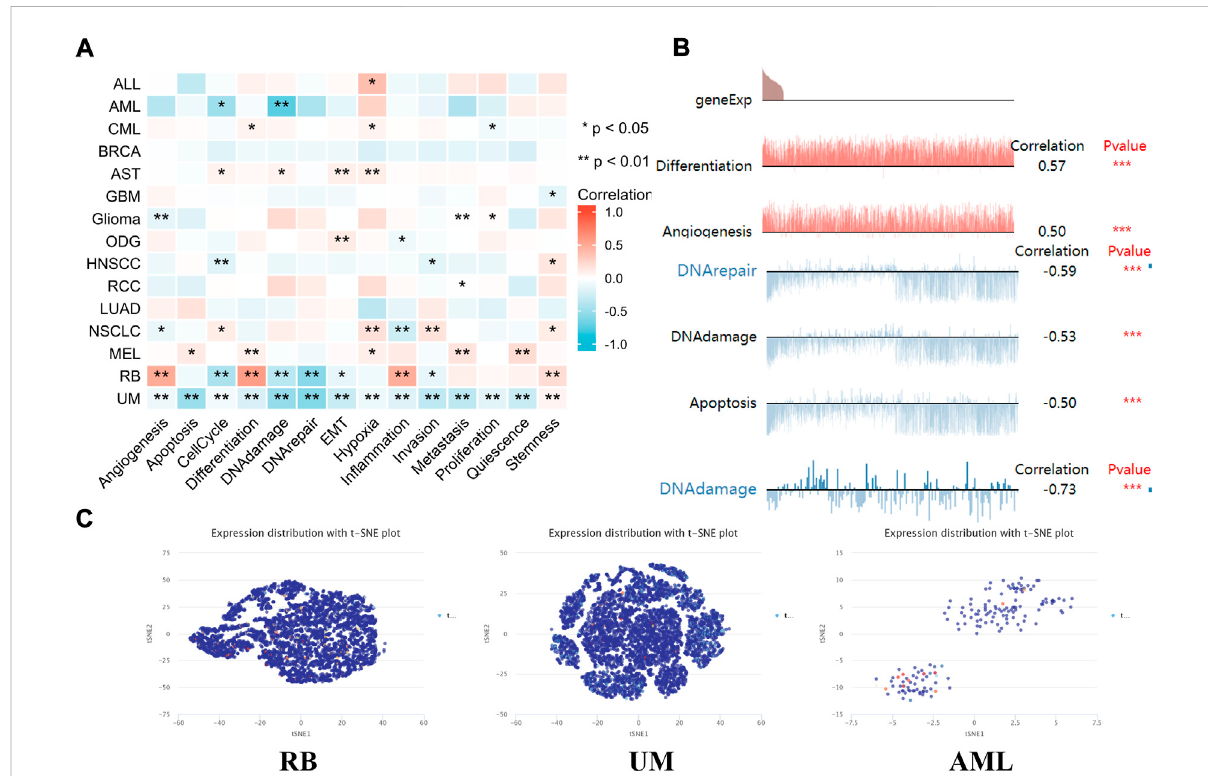
FIGURE 7 TheexpressionlevelsofLIPT1atsingle-celllevels. (A,B) TherelationshipbetweenLIPT1expressionanddifferentfunctionalstatesintumorswas exploredbytheCancerSEAtool.* p < 0.05;** p < 0.01;*** p < 0.001. (C) LIPT1expressionpro fi leswereshownatsinglecellsfromRB,UMandAMLby T-SNE